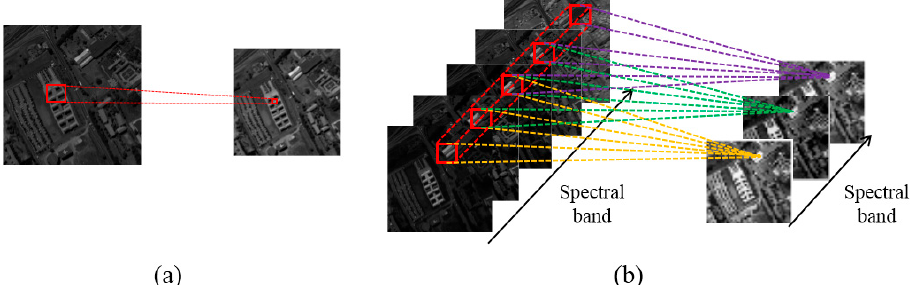
Figure 1. ( a ) 2D convolution operation, as per Formula (1); ( b ) 3D convolution operation, as per Formula (2).